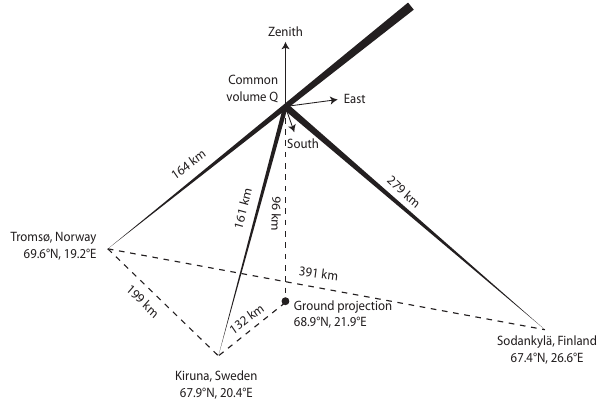
Fig. 1. Schematic illustration of the experimental geometry. Radar pulses are transmitted from the Tromsø, Norway radar site and scat- tered from targets in the common scattering volume at Q . The scat- tered signals are received at Tromsø, Kiruna and Sodankyl ¨